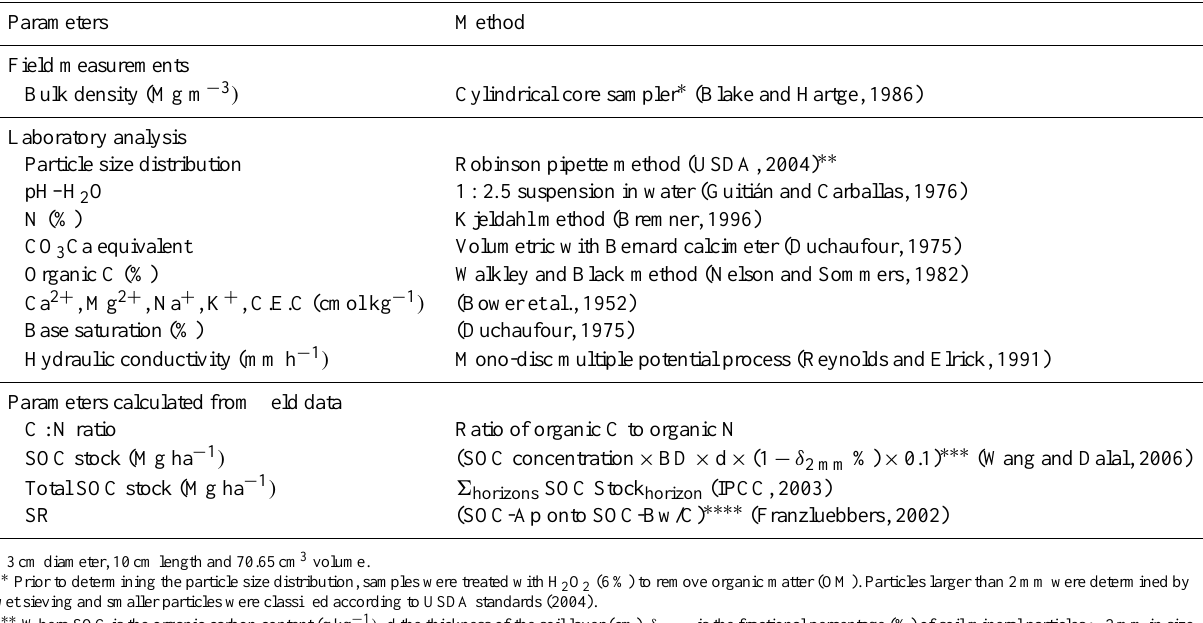
Table 1. Methods used in field measurements, laboratory analysis and calculated from field data.